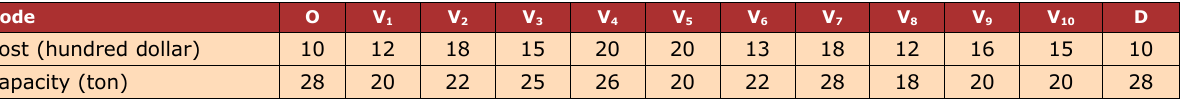
Table 1. The data of nodes for the 12-node